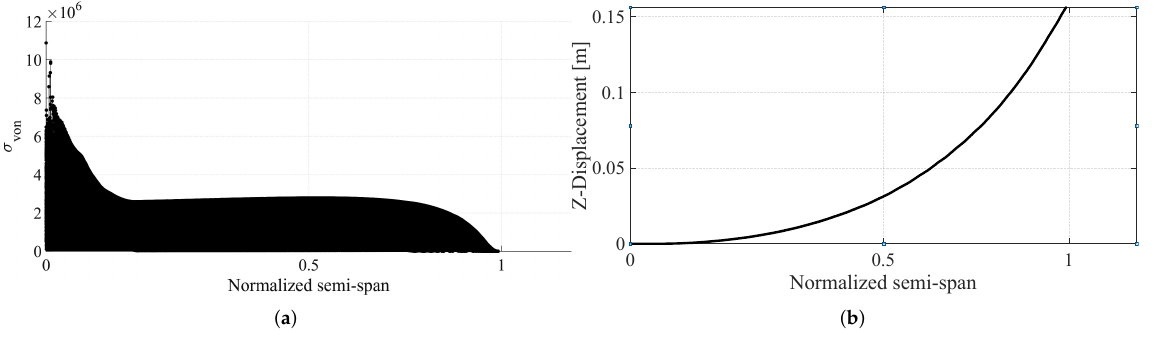
Figure 12. The von Mises distribution [Pa] ( a ) and the vertical displacement ( b ) along semi-span.